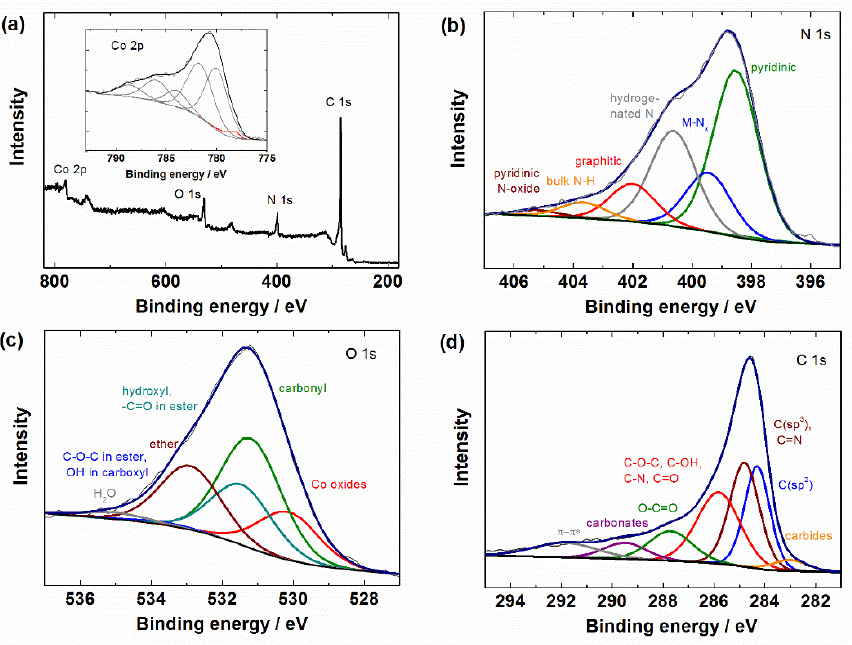
Figure 3. X-ray photoelectron spectra for Glu-NC-8Co catalyst: survey spectrum ( a ) and deconvoluted detailed spectra in Co 2p region (inset of ( a )), N 1s region ( b ), O 1s region ( c ) and C 1s region ( d ).